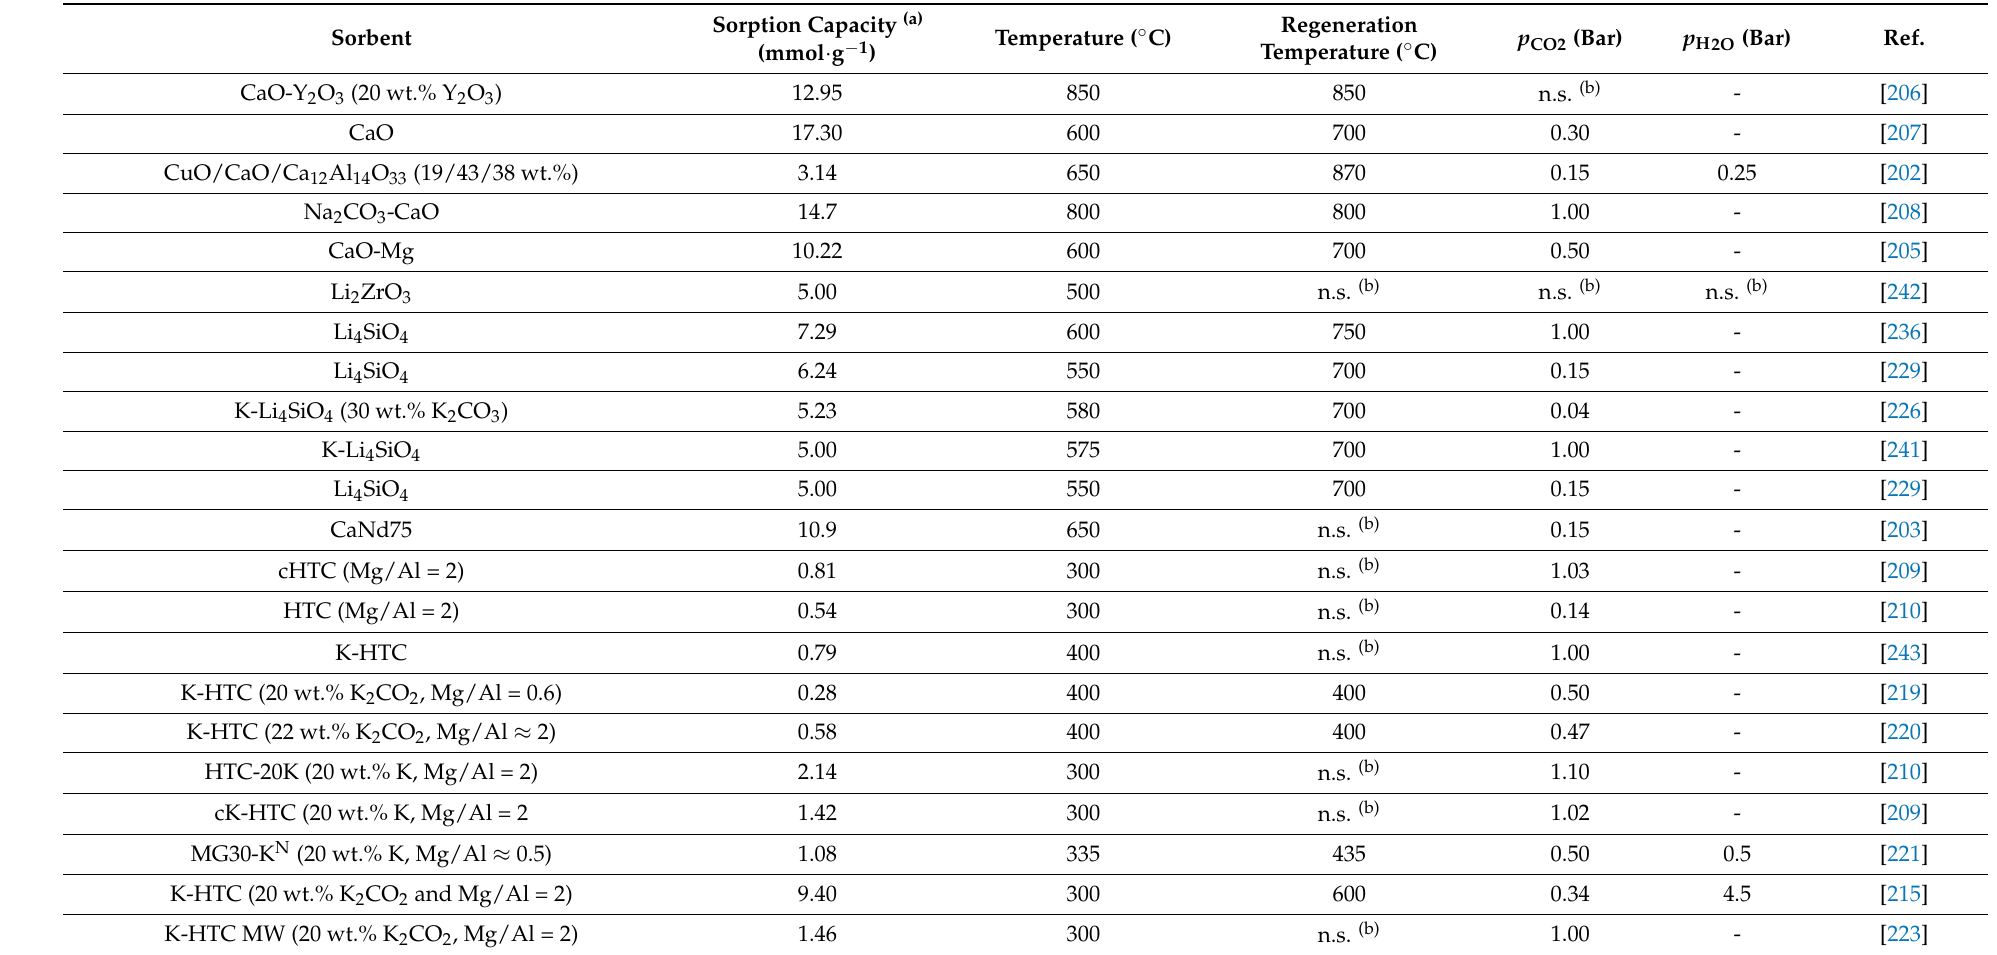
Table 6. Sorption capacities and sorption/regeneration temperatures of several CO 2